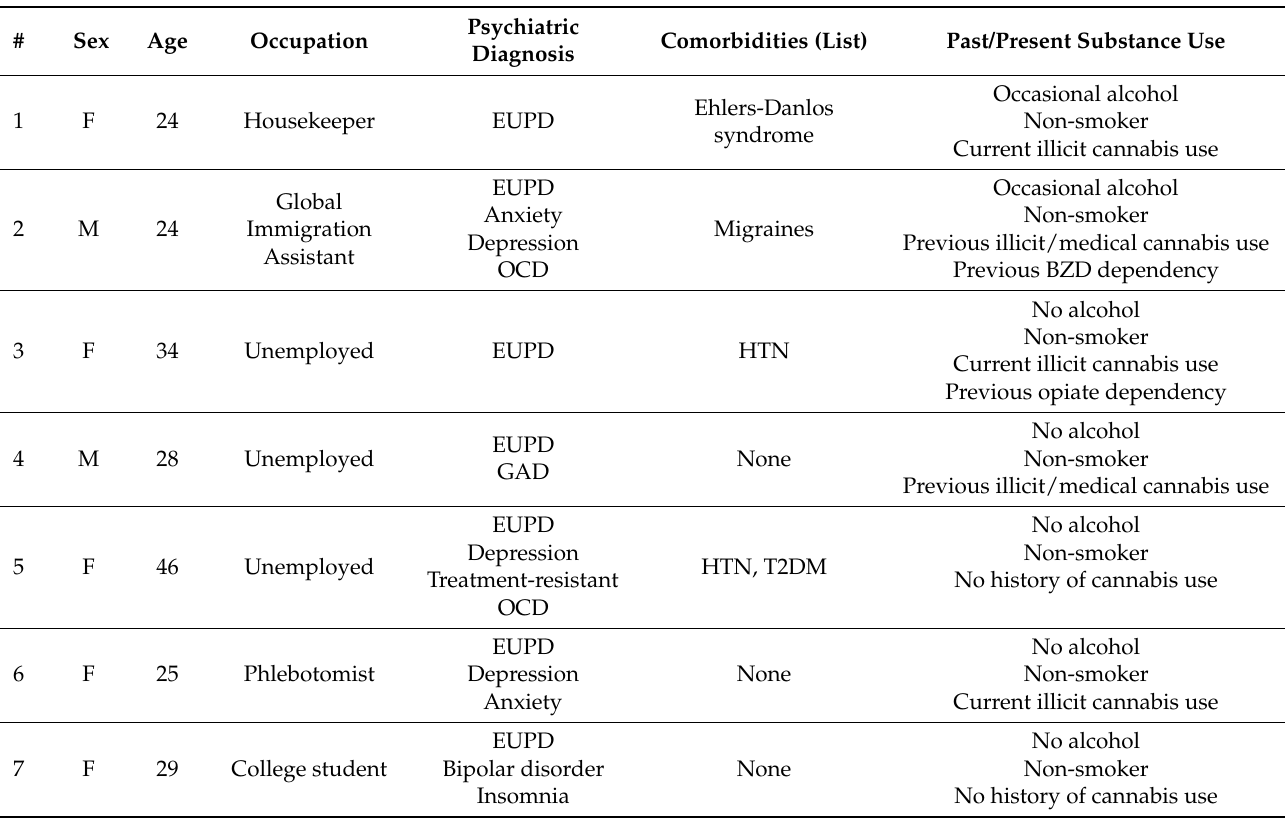
Table 1. Basic demographics, clinical presentation, and substance use of seven patients presenting to Zerenia clinics with a diagnosis of EUPD. Current illicit cannabis users reported consuming every day or every other day. Occasional alcohol use represents less than 4 units a week.